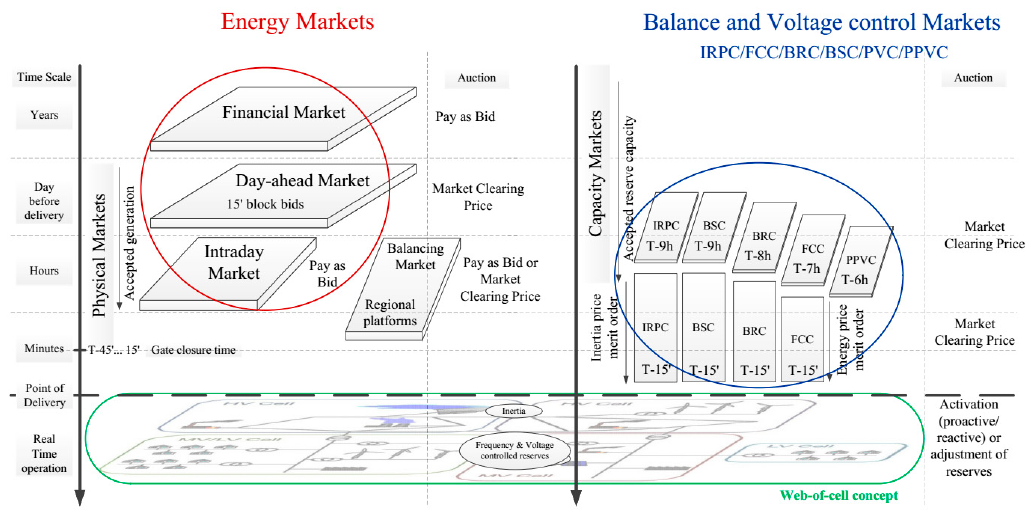
Figure 4. General structure of the electricity market within the WoC concept [5].